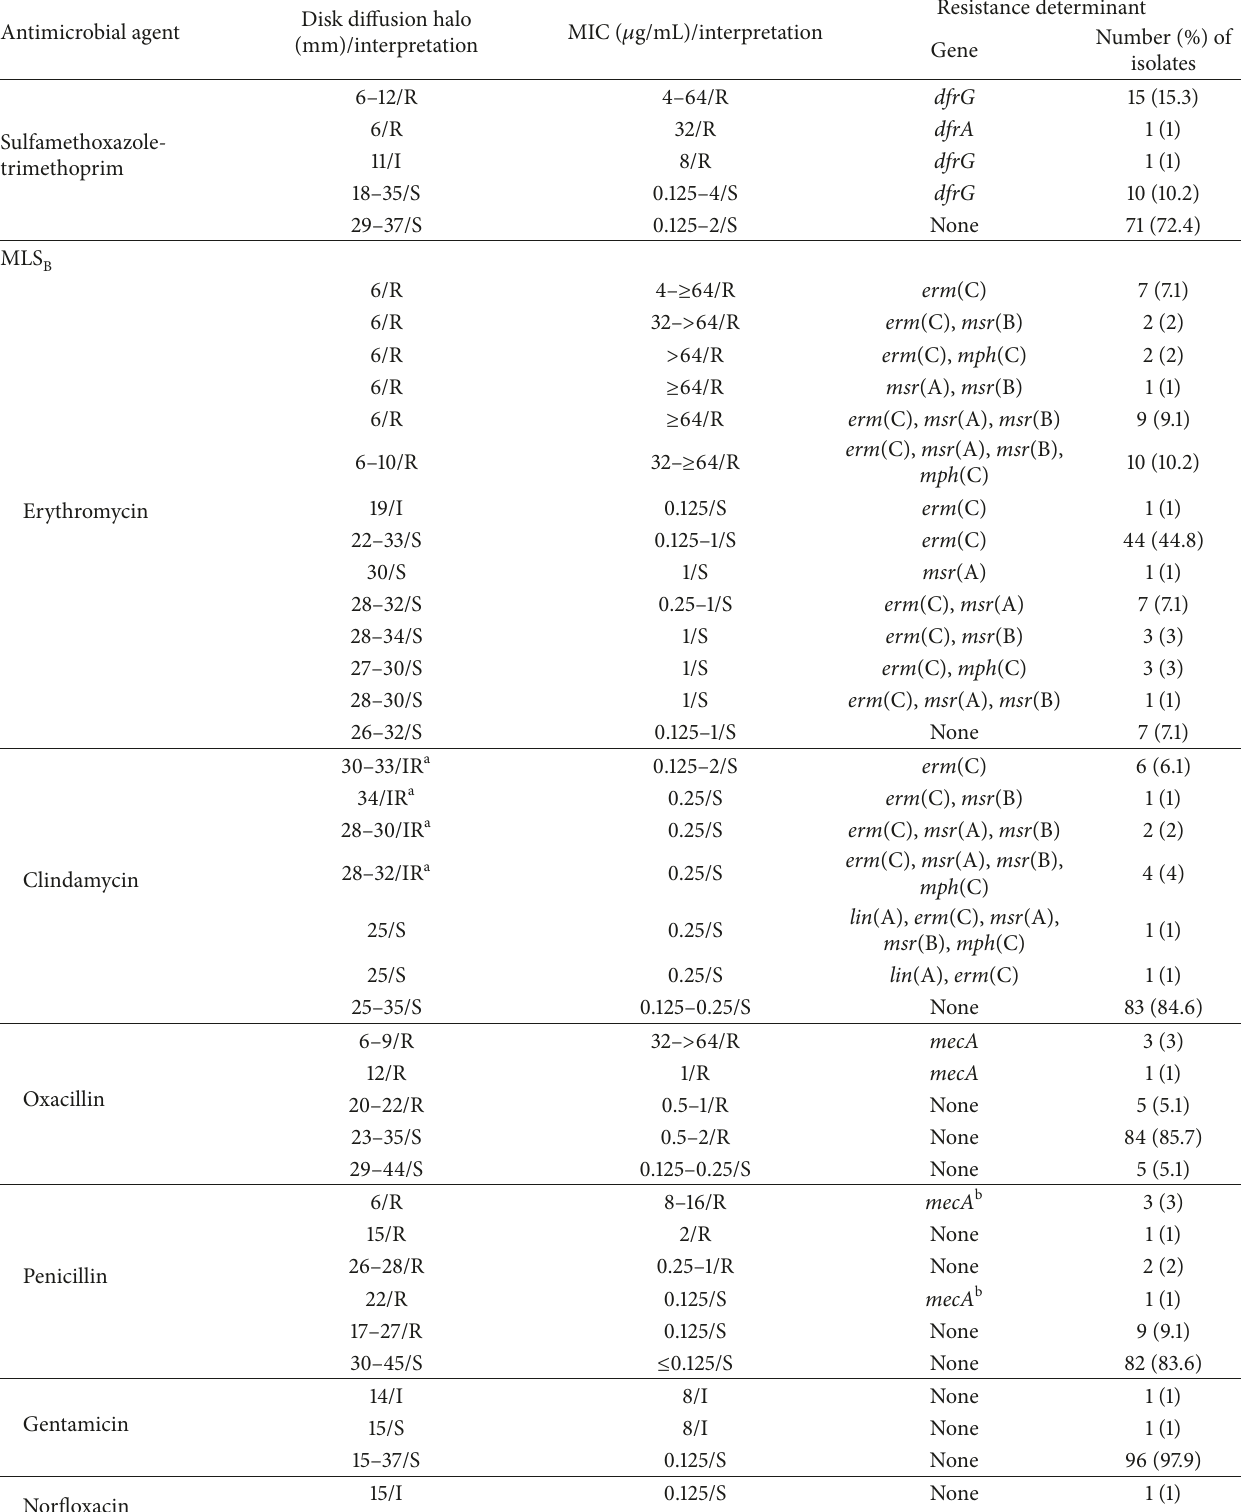
Table 3: Antimicrobial susceptibility and resistance determinants in 98 Staphylococcus saprophyticus isolates. Antimicrobial